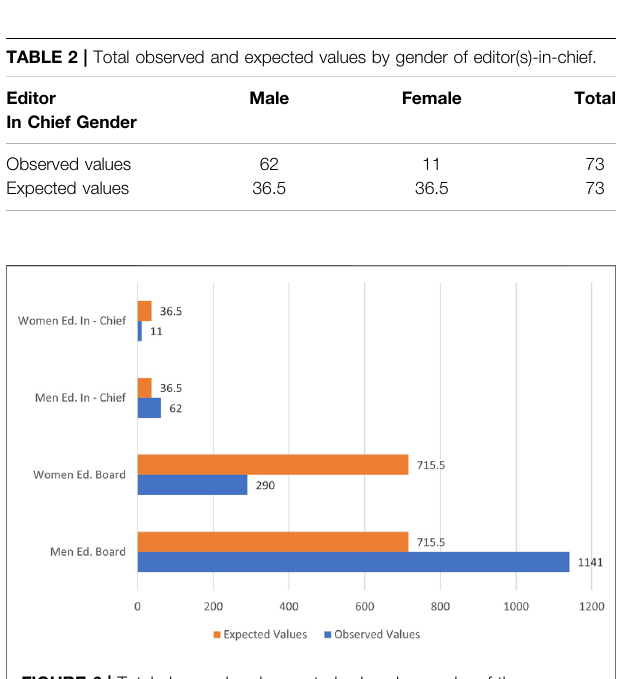
Frontiers in Earth Science |